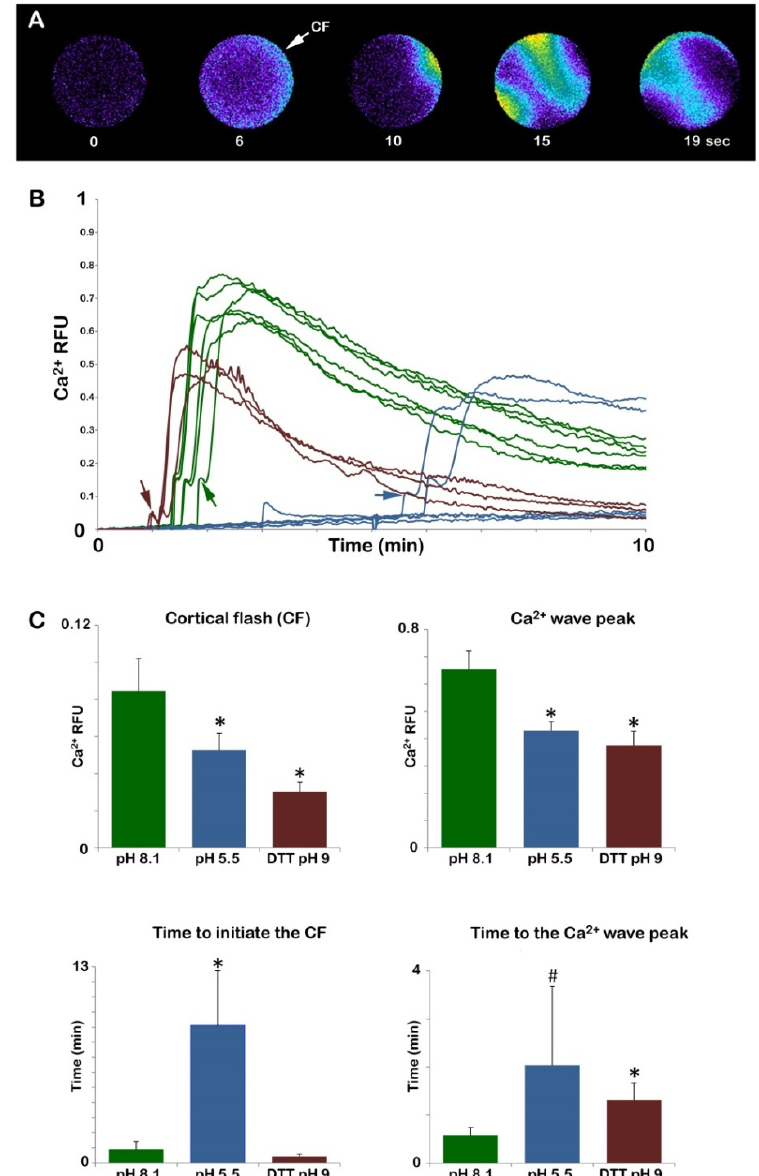
Figure 4. Alteration of the Ca 2+ responses in P. lividus eggs fertilized after removing the jelly coat (acidic seawater) or stripping the VL (DTT, pH 9). P. lividus eggs were microinjected with the calcium dye before treating them with acidic seawater or 10 mM of DTT for 20 min (pH 9) to remove the vitelline layer. After several washes in NSW (pH 8.1), the Ca 2+ response of denuded eggs was compared with that of the control eggs and the eggs inseminated in acidic seawater (pH 5.5). The pseudocolor images in ( A ) show the instantaneous increases in Ca 2+ levels extracted from a time- lapse acquisition following fertilization of the denuded eggs, i.e., deprived of both the vitelline and jelly layers. The initial Ca 2+ signal in the cortical region of the egg (CF) was followed by two Ca 2+ waves as a result of polyspermic fertilization. The graphs and histograms in (B) and (C) show a comparison of the sperm-induced Ca 2+ increases in the three different experimental conditions. The heights of the CF (arrows) and Ca 2+ wave in the eggs fertilized in NSW (pH 8.1) (green lines) are higher than those fertilized in acidic seawater (blue lines) and the denuded eggs (red lines). The graphs and histograms (( B ) and ( C )) of the Ca 2+ releases in the eggs fertilized in acidic seawater show a time delay between the addition of the sperm to the Ca 2+ measurement chamber in which the eggs were suspended as compared to the other experimental conditions. Tukey’s post hoc test * p < 0.01, # p < 0.05. RFU = relative fluorescence unit.